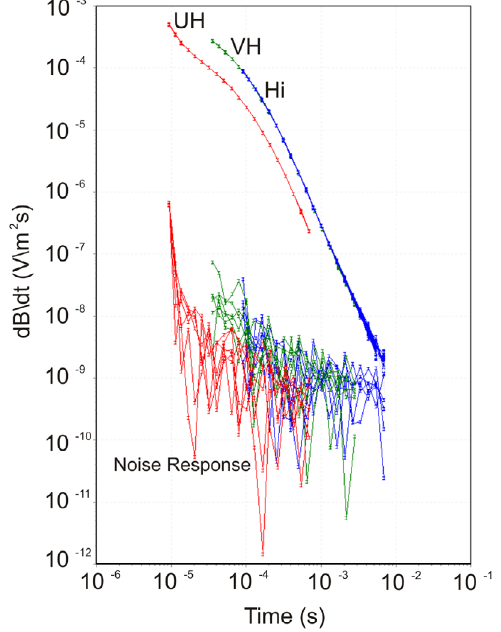
Figure 4. Signal and noise responses measured for the ultra high (UH), very high (VH), and high (HI) segments. The color used for the TEM response, in a given time segment, corresponds to that for noise values measured in the same time